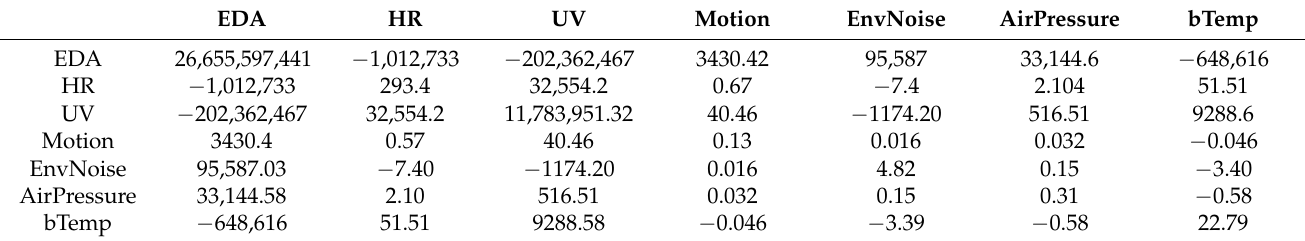
Table 8. Covariance Matrix of all on-body and environmental